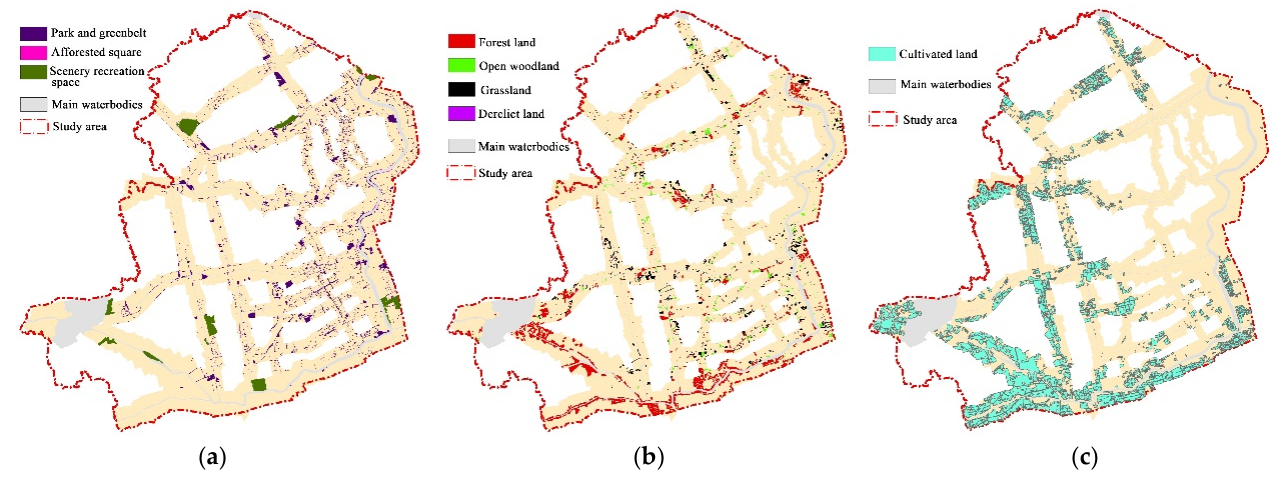
Figure 8. Distribution pattern of three classes of greenspace in the study area based on service function. ( a ) Recreational greenspace system; ( b ) ecological conservation land system; ( c ) agricultural use area system.